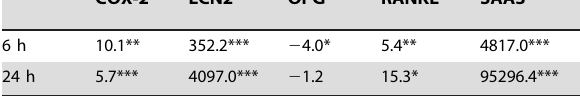
Table S1 List of genes regulated after 6 h in response to Porphyromonas gingivalis. Table S2 List of genes regulated after 24 h in response to Porphyromonas gingivalis.